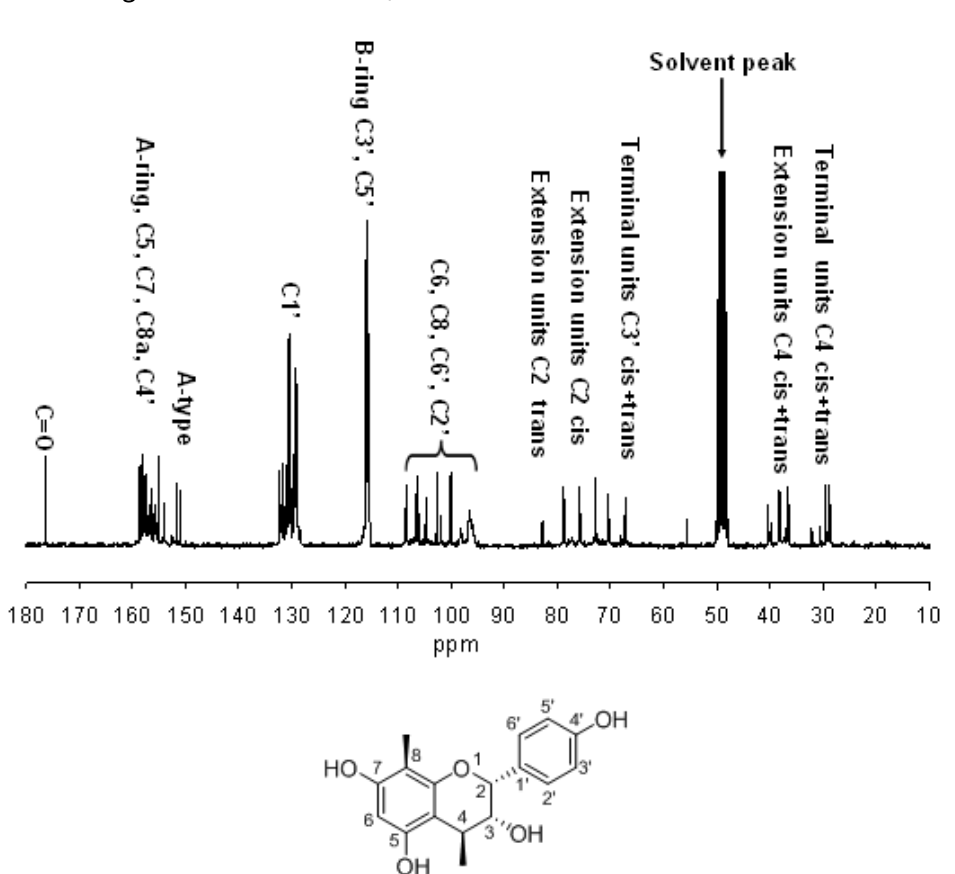
Figure 3. Room temperature 75 MHz 13 C-NMR spectrum of proanthocyanidins from the rhizomes of Selliguea feei (solvent CD 3